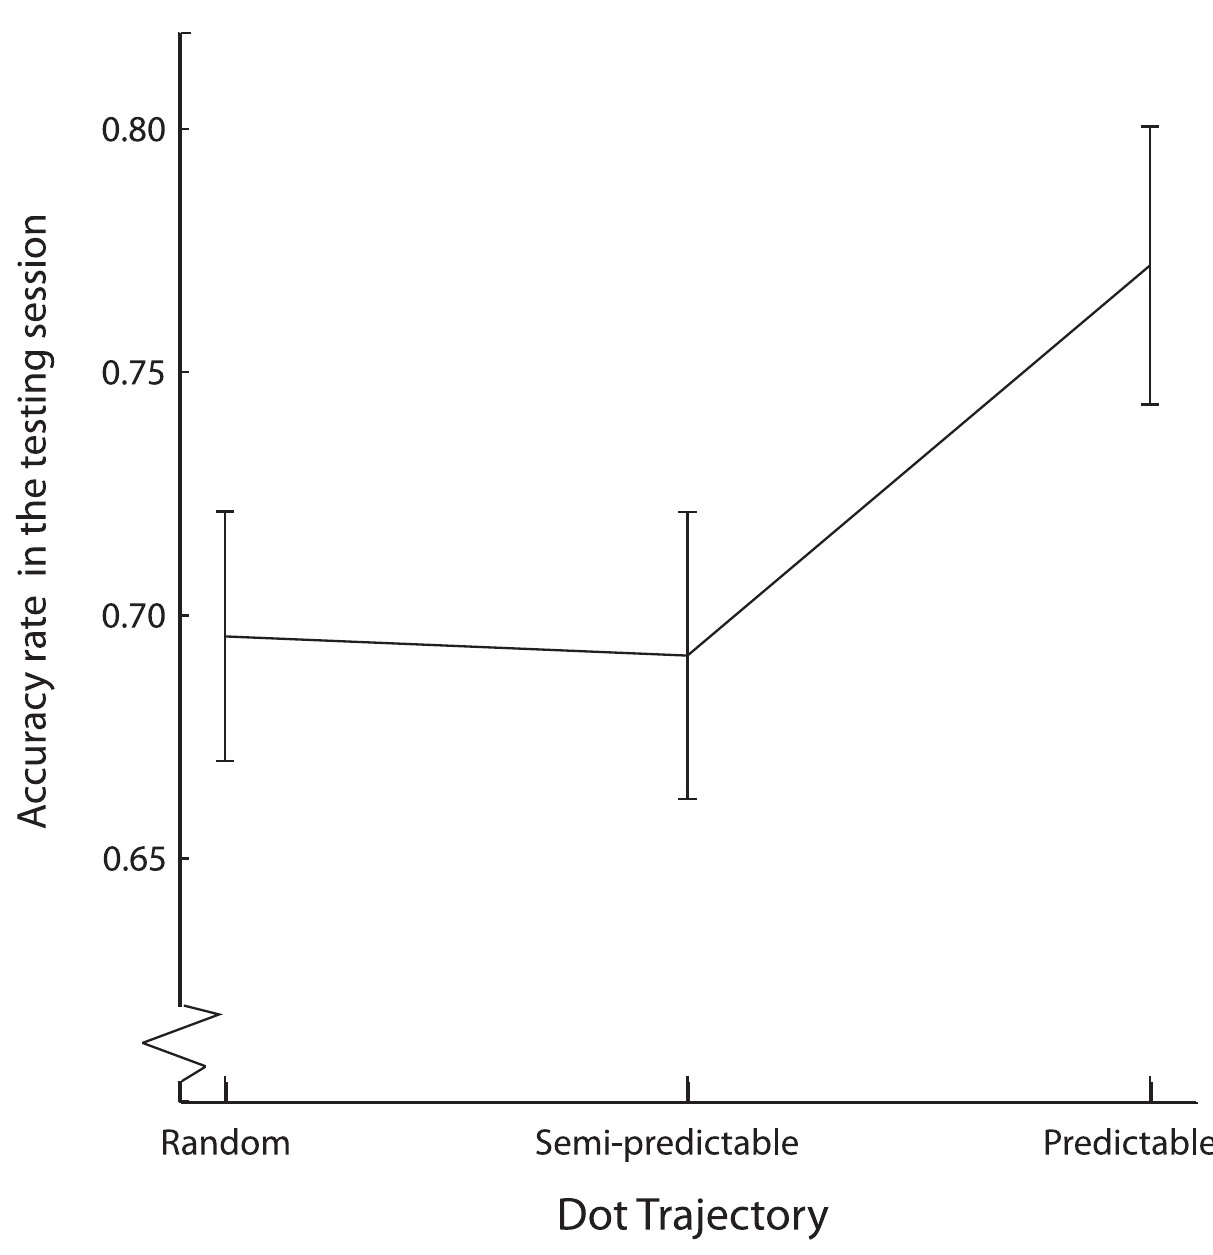
Fig 3. Accuracyrates in the testing session, depending on the dot trajectoryaccompanying the static stimulus. Accuracy is collapsedacross tasks. Error bars denotewithin-subjects 95% confidenceintervals.